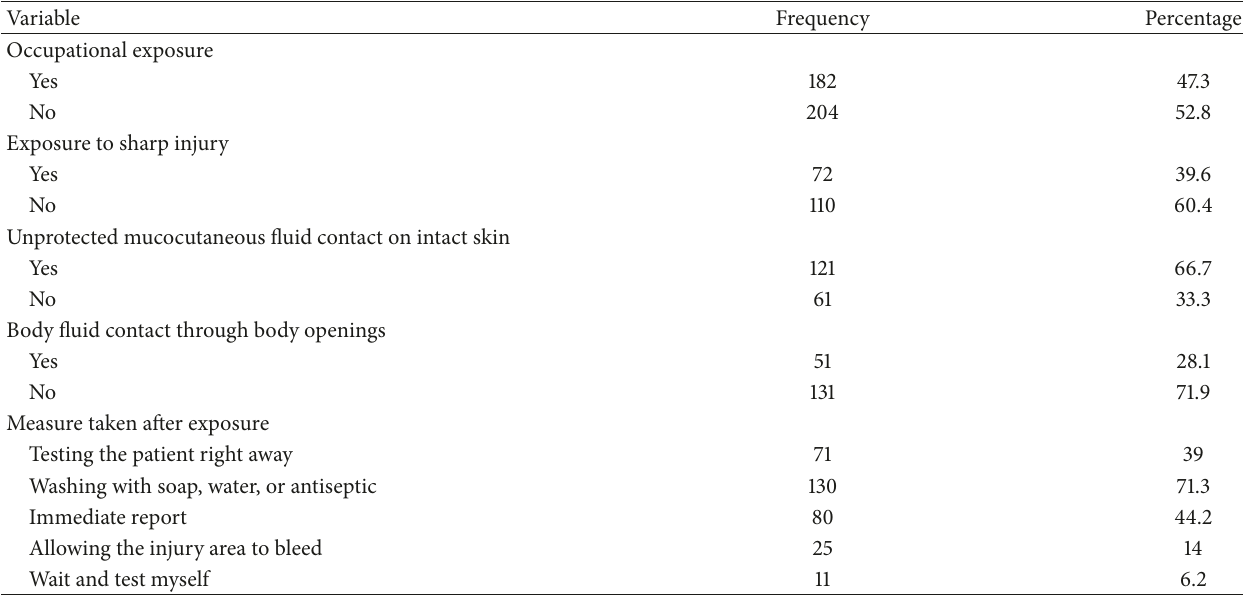
Table 3: Exposure to occupational risk of hepatitis B among health professionals, AHMC, Ethiopia, in 2017. Variable